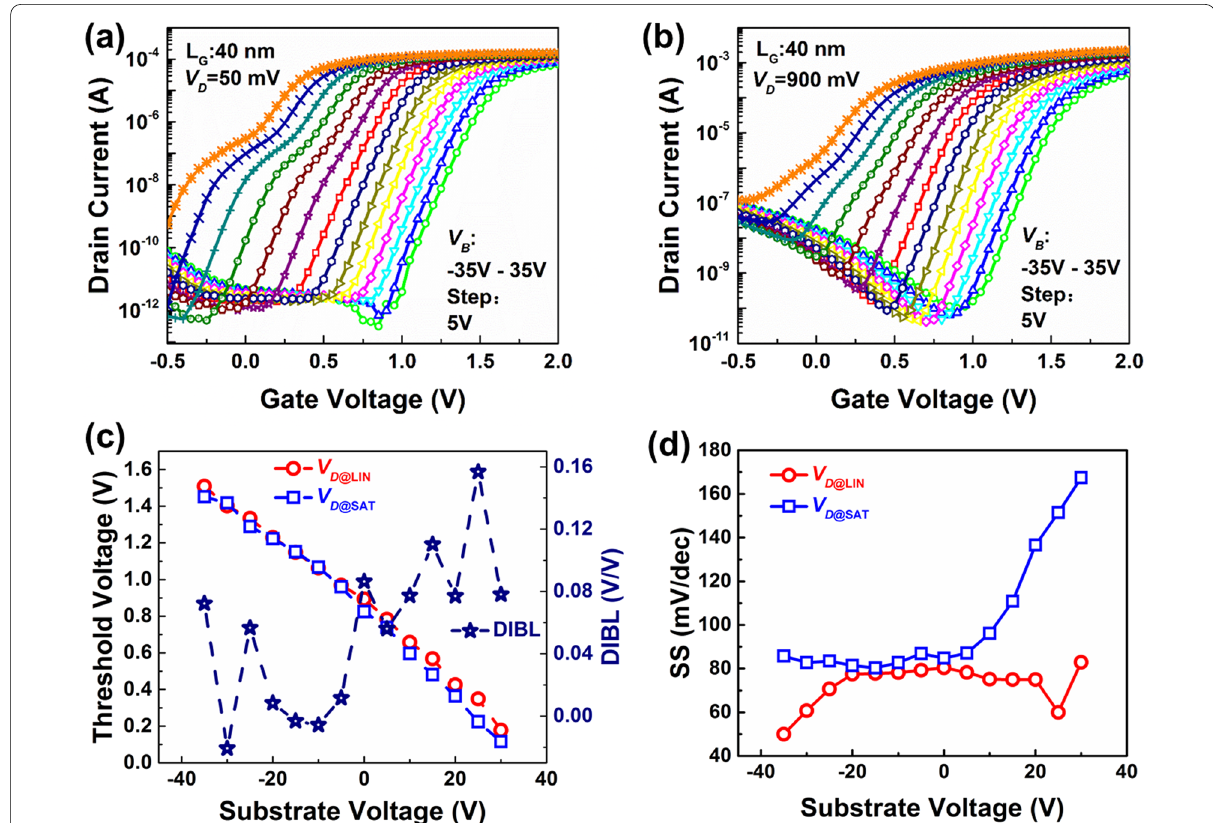
Fig. 3 Impacts of back bias voltages on transfer curves of FE ETSOI FET, with ( a ) V DS V T s and DIBLs under various V SUB s of the device in Fig. 3a. ( d ) Extracted SSs under various V SUB s of the device in Fig. 3a and (b).